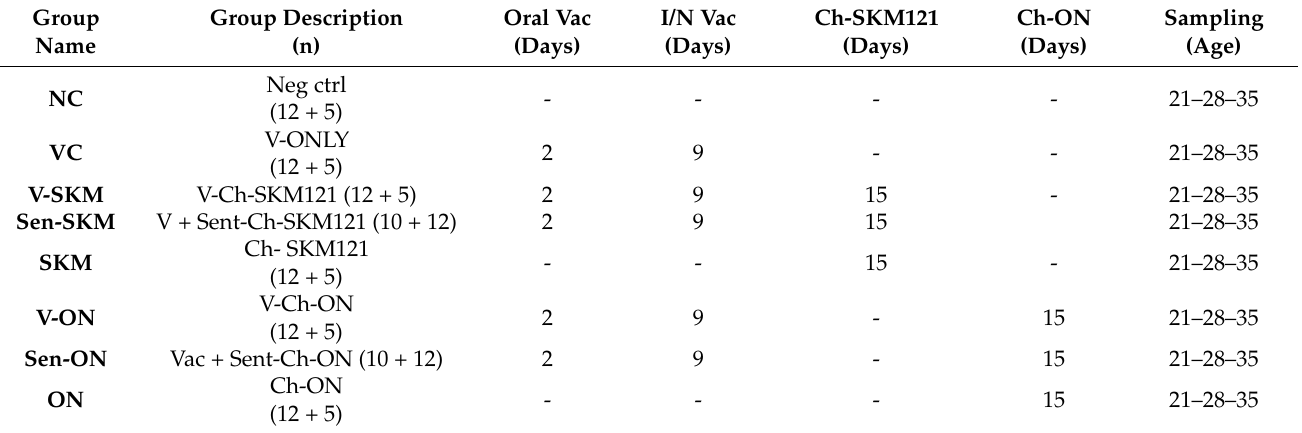
Table 1. Summary of experimental